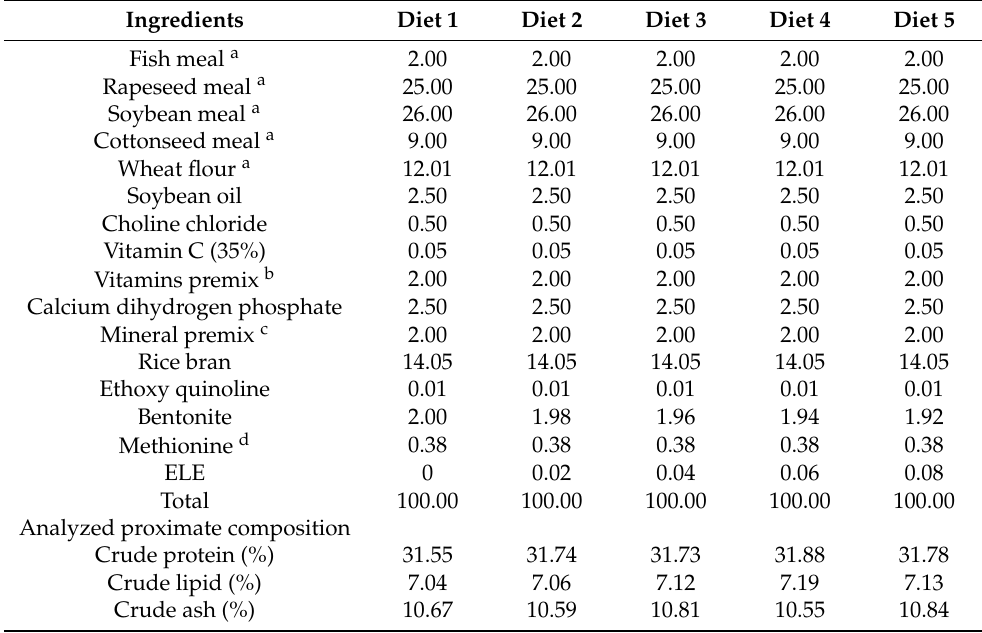
Table 1. Ingredients and proximate composition of experimental diets (%, dry